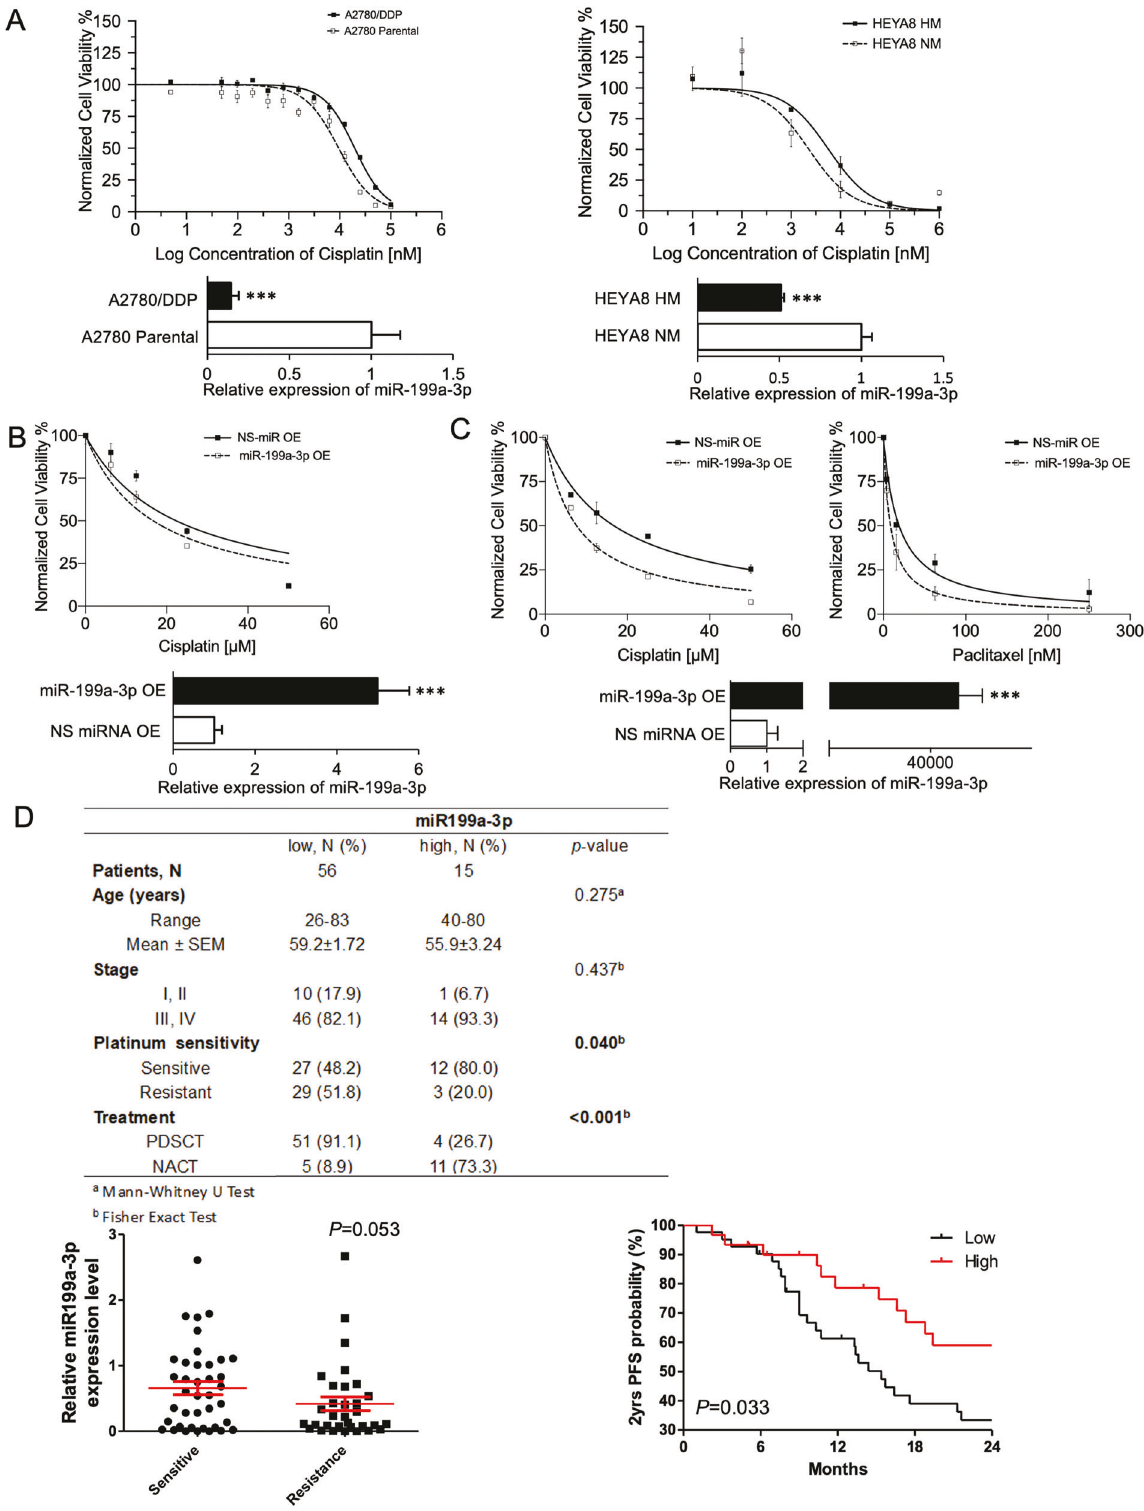
Fig. 5 miR-199a-3p enhances chemosensitivity and stemness in ovarian cancer cells. A Dose – response curve of A2780 Parental vs. A2780/ DDP cells (left), and HEYA8 HM vs. HEYA8 NM cells (right) against cisplatin. B Dose – response curve of miR-199a-3p-overexpressing A2780/DDP cells (left) against cisplatin and C against cisplatin/paclitaxel for SKOV-3 cells (right). The miR-199a-3p-overexpressing SKOV-3 cells were divided into two groups: cisplatin and paclitaxel treatment. D Expression of miR-199a-3p in chemosensitive vs. chemoresistant patient tumors and Kaplan – Meier Survival analysis for patient strati fi ed by miR-199a-3p expression, and clinicopathological table of patients. Bar graph values are mean ± SD, n = 3. T -test. * P < 0.05, ** P < 0.005. Statistical analysis for patient samples is mentioned in clinicopathological table.